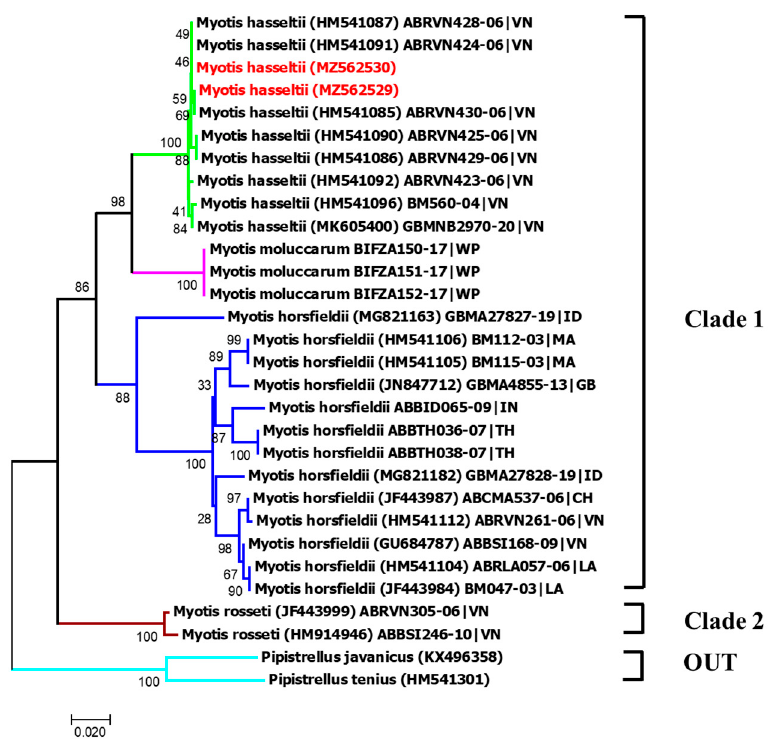
Figure 19. Molecular phylogenetic analysis of Myotis hasseltii samples collected in Cat Ba Island based on the aligned COI sequences. Two COI sequences generated in this study and 28 reference sequences obtained from the BOLD system were aligned by BioEdit software using ClustalW algorithm. The phylogenetic tree was built in MEGA v7.0. The bootstrap value with 1000 replicates is indicated next to each branch. The scale bar shows the number of nucleotide changes per